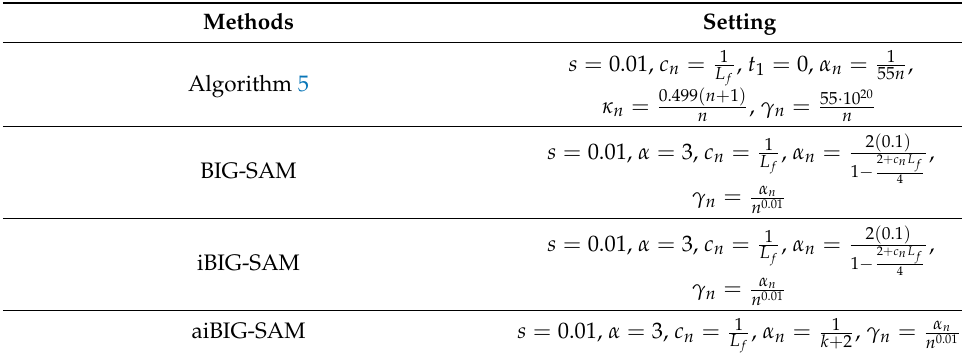
Table 1. Setting parameters of each